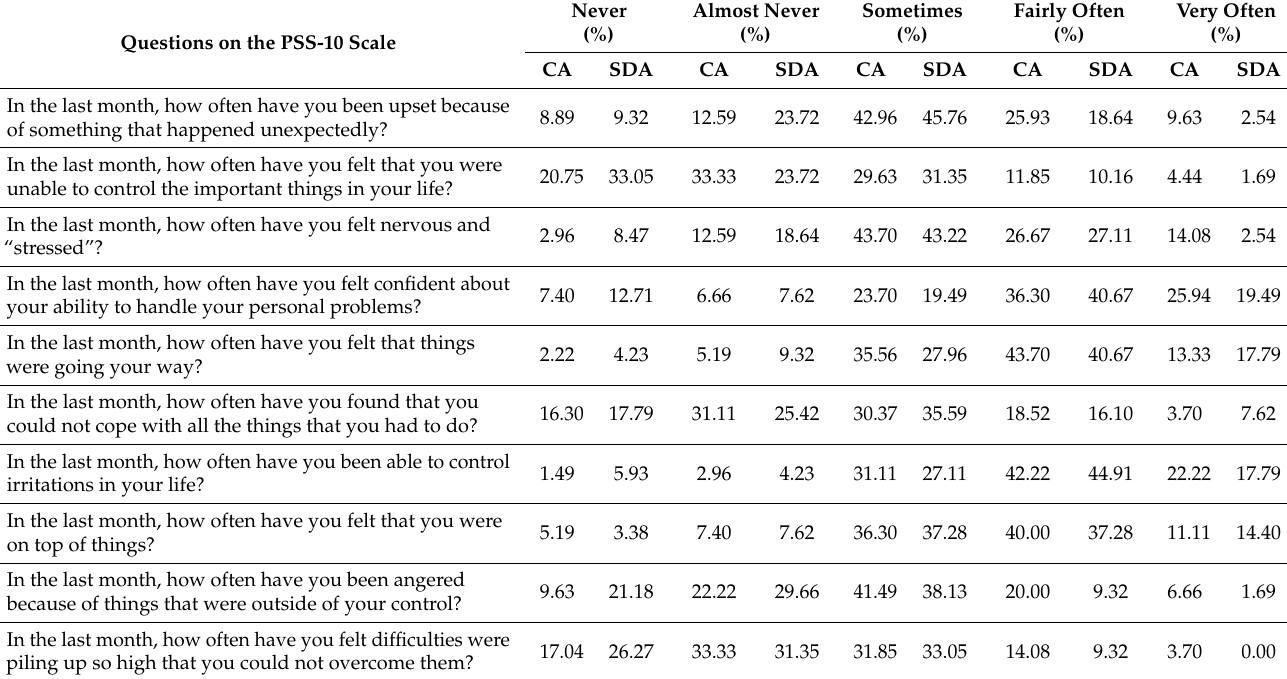
Table 8. Detailed breakdown of answers by studied SDA and CA on the PSS-10